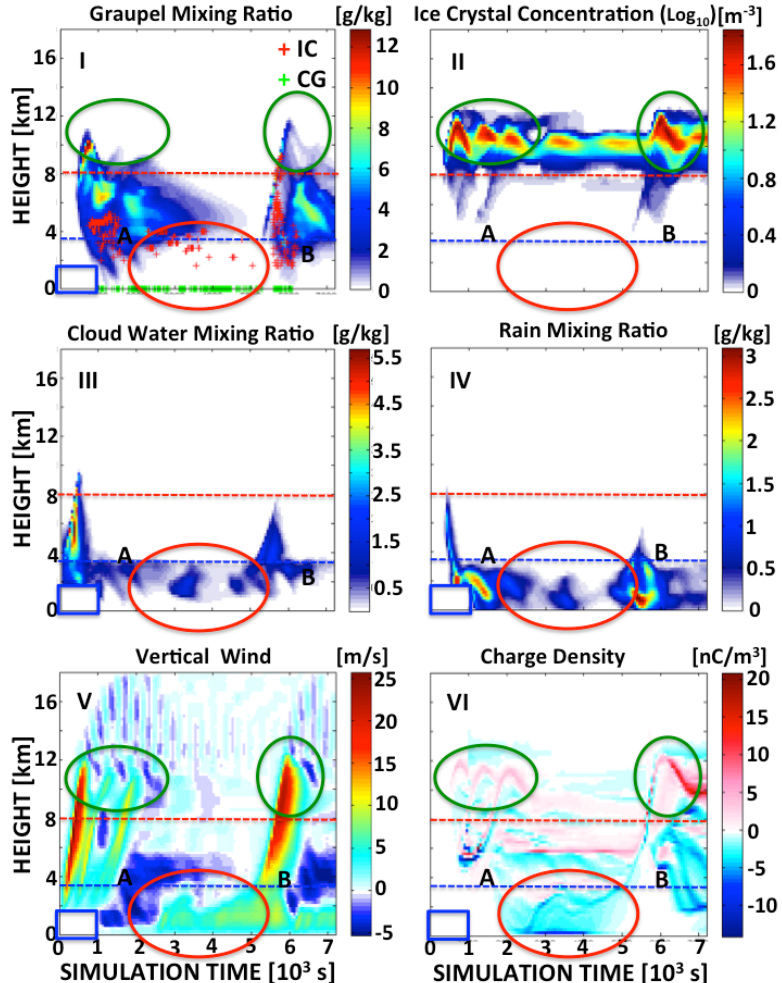
Fig. 12. Temporal evolution of hydrometeor mixing ratios (gkg − 1 ), lightning occurrences, vertical wind (ms − 1 ) and charge density (nCm − 3 ) for Case 1 (Munich, 29 July 2008). The panels show: (I) graupel mixing ratio and lightning, (II) ice crystals concentration expressed in a log 10 scale, (III) cloud water mixing ratio, (IV) rain mixing ratio, (V) vertical wind, and (VI) charge density. Results are shown as a function of simulation time and height. The dotted red and blue lines mark the charging zone (CZ in the text). In panel (I) the IC are red crosses at the height where they initiate, and the CG are green crosses (shown at the surface). Each column represents a time step of 60s. The red circle evidences a phase of negative charge density at low levels (see text). The green circles highlight the presence of high concentration of ice crystals at high levels associated to high positive charge density. Letters A and B evidence the phases of intense IC activity. The blue rectangle evidences the cloud initiation